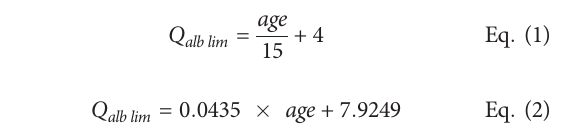
FIGURE 1 | Flowchart of patients included in the study. CIS, clinically isolated syndrome; FU, follow-up; PPMS, primary progressive MS; RBC, red blood cell; RRMS, relapsing remitting MS; SPMS, secondary progressive